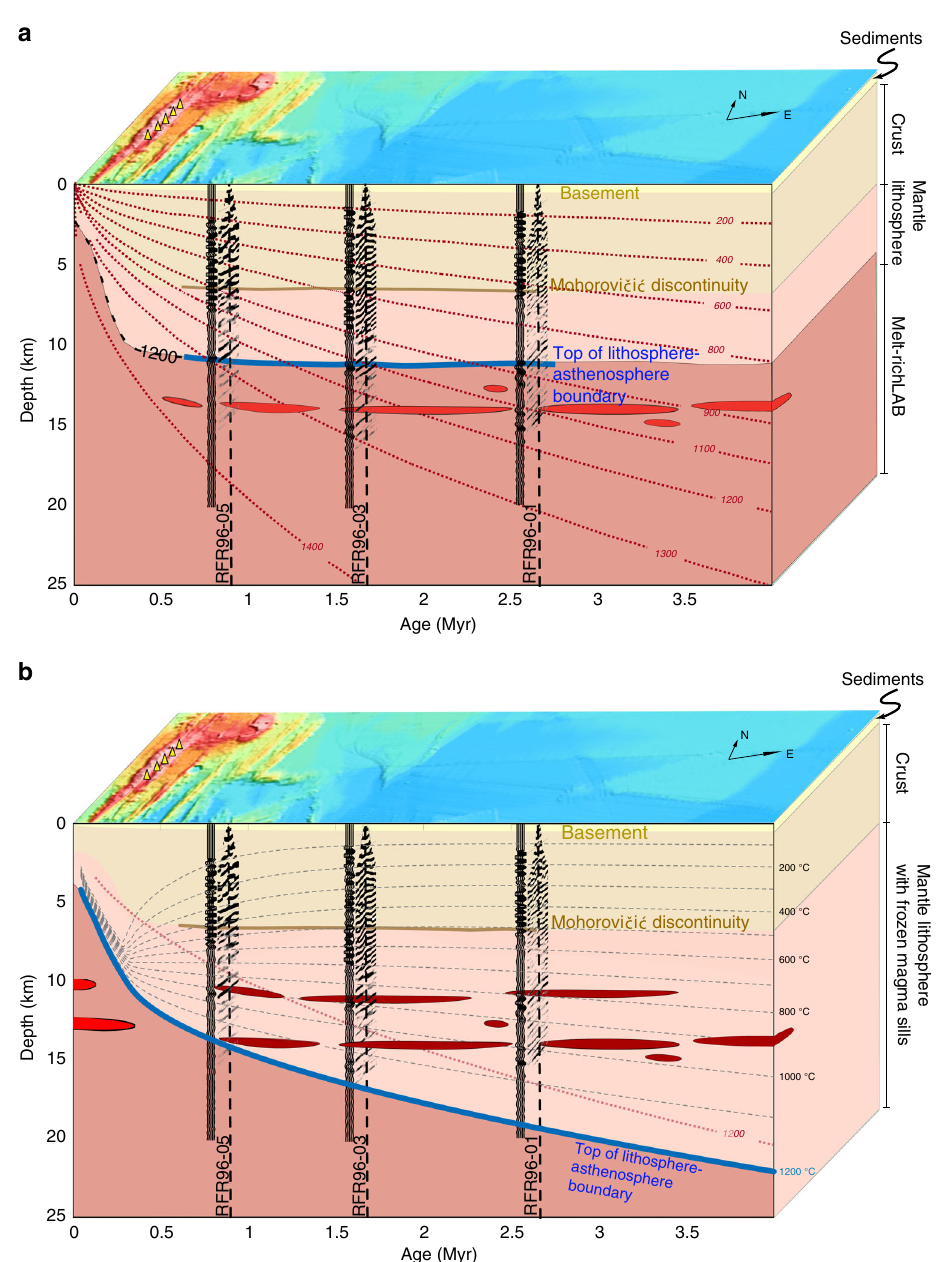
Fig. 6 Thin lithosphere with fl at lithosphere – asthenosphere boundary (LAB) versus thick lithosphere. A schematic diagram showing two different models of the LAB. a Thin lithosphere and fl at LAB: The top re fl ector imaged in the seismic sections (Fig. 3) is interpreted as the top of the LAB (blue). The deeper re fl ectors are interpreted as a presence of melt pockets (red ellipses). Pre-stack migrated traces at the crossing of three seismic pro fi les with the ridge perpendicular seismic re fl ection pro fi le (black-white dashed line in Fig. 1) are shown. The red dotted lines represent isotherms calculated using the plate-cooling model 62 . Bathymetry is shown at an angle to add ‘ depth ’ to the two-dimensional illustration. The yellow triangles indicate hydrothermal vent fi elds. b Thick and heterogeneous lithosphere: The isotherms are represented by grey dashed lines obtained by the approach 3 described in Methods. The thick blue line marks the base of the thick and heterogeneous lithosphere. The red dashed curve is the 1200°C isotherm based on the plate-cooling model in ( a